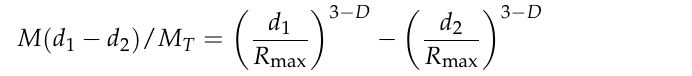
Table 1. Numerical test scheme.